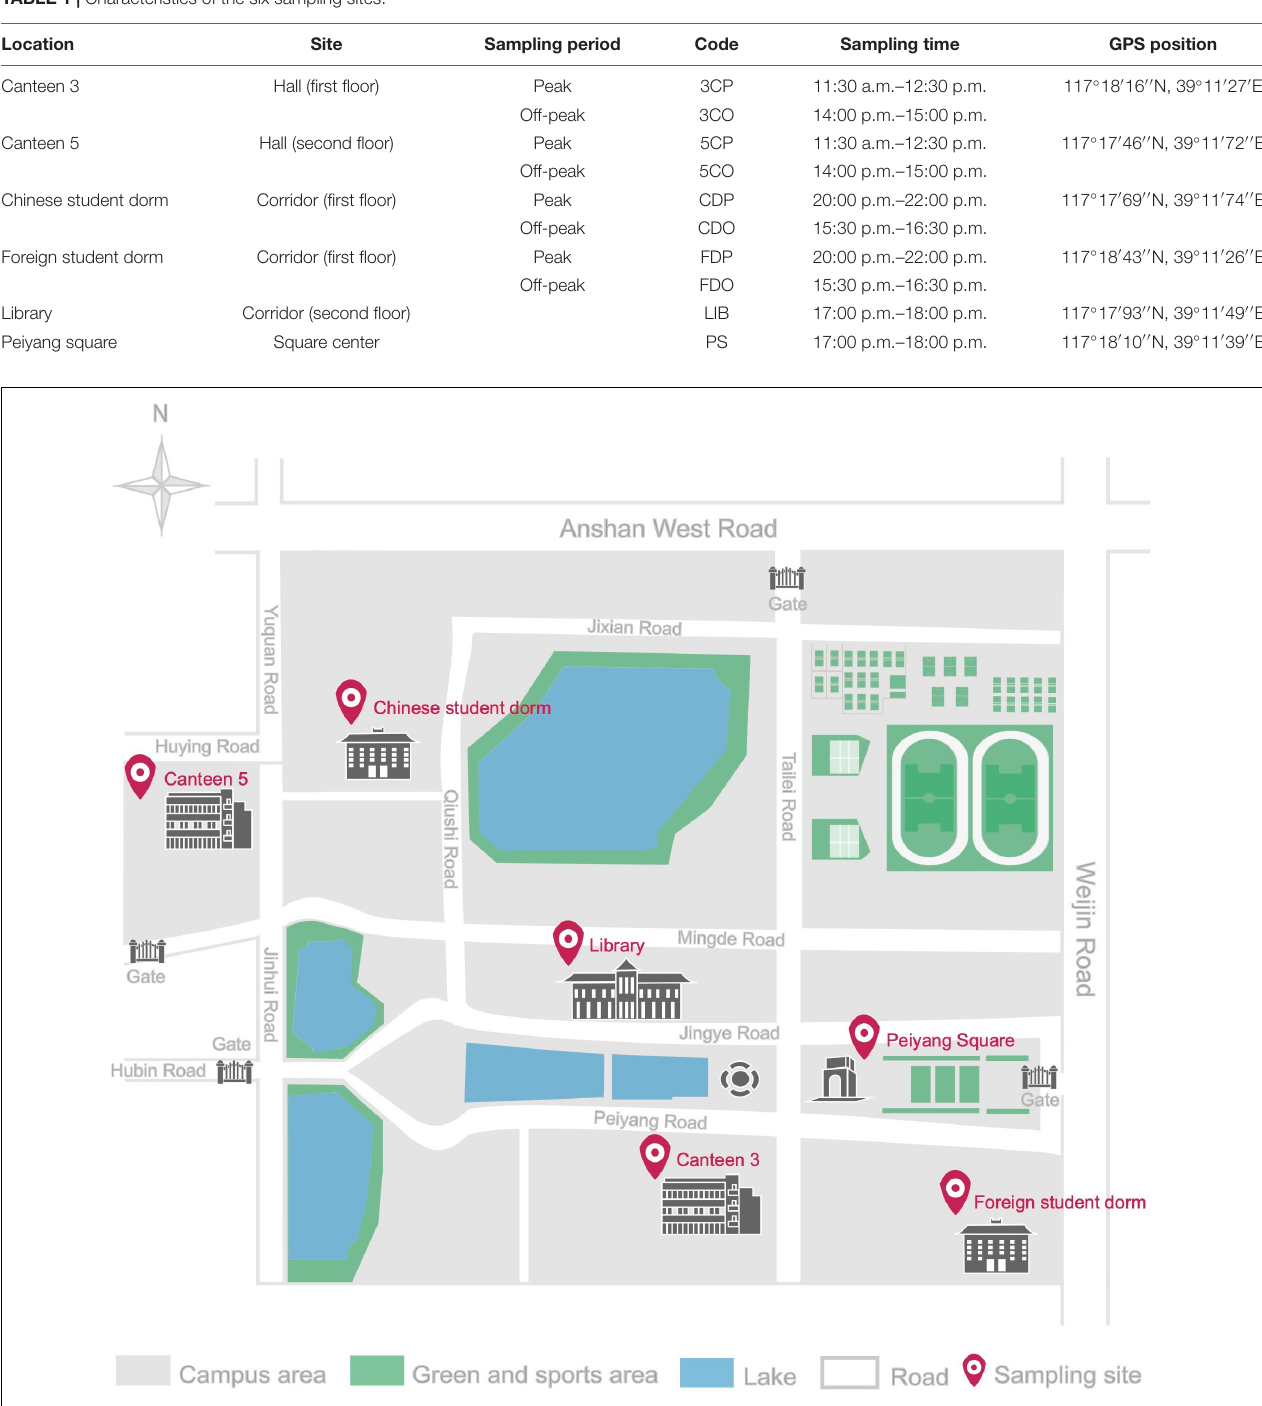
FIGURE 1 | Schematic diagram of Tianjin University Campus in Nankai district, with detailed location of the six sampling sites.